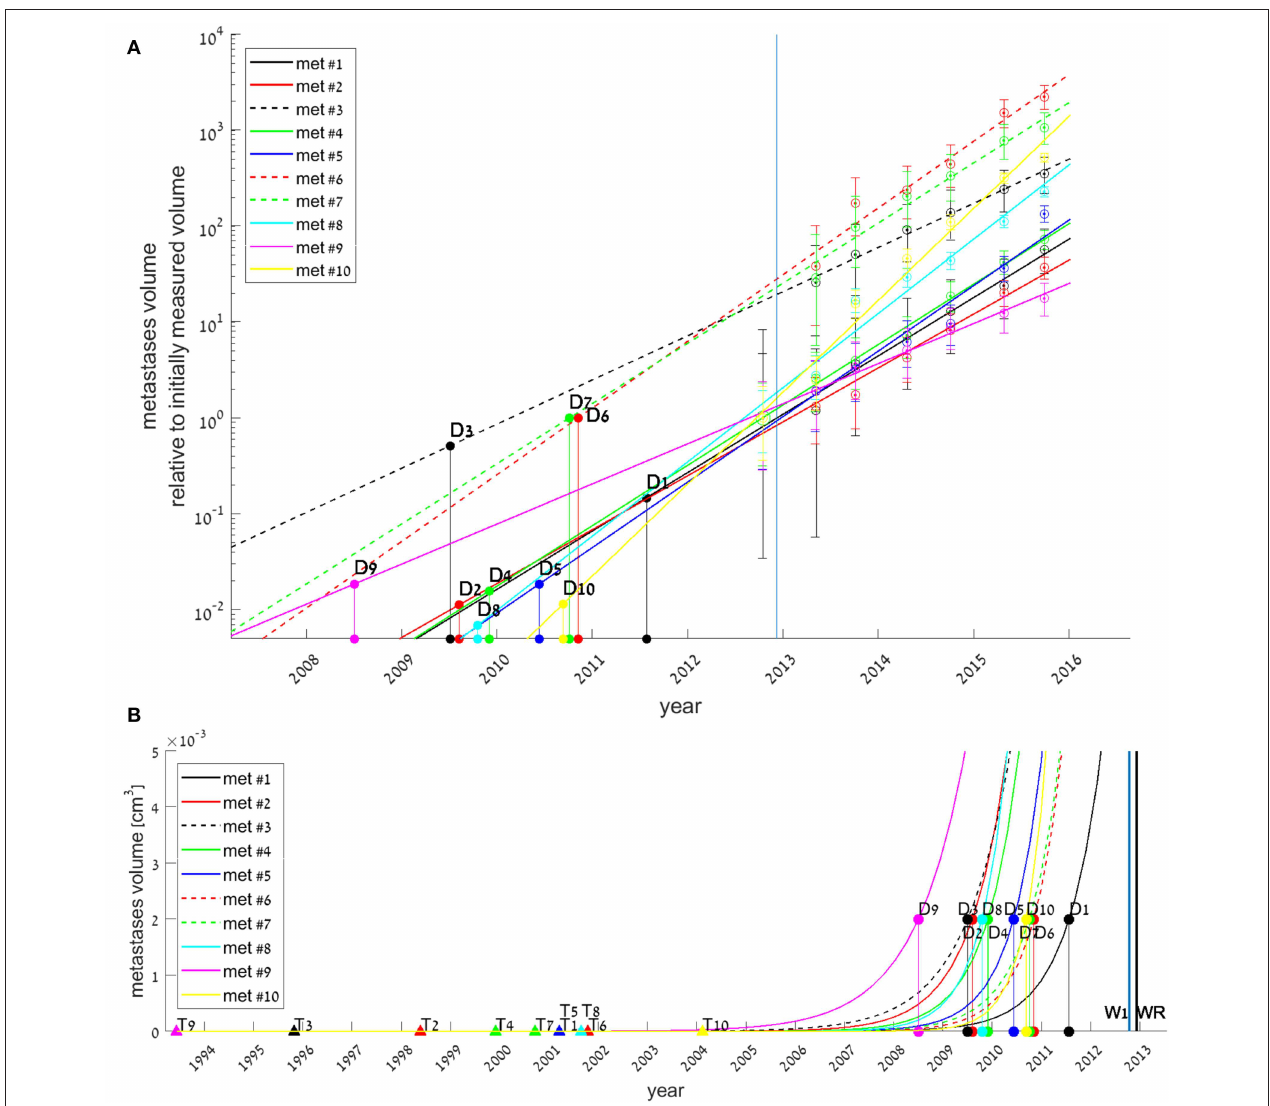
FIGURE 3 | Exponential growth law fits for all 10 metastases (colored lines), with estimated date for each metastasis onset (filled triangles, marked by T k for each metastasis # k ), and estimated date for its earliest possible detection (filled circles, D k ). T k and D k values were extrapolated from the fitted models, assuming growth rates did not change since metastasis’ onset. In (A) , measured volumes are normalized to each metastasis initial volume at time W1. Early growth of metastasis ( < 0.005 cm 3 ) is not presented, hence T k values are not shown. In (B) , early growth of metastasis is presented, and the whole timeline of the disease natural history is shown. Blue and black vertical lines represent the days of disease detection (W1) and of primary tumor resection (WR),